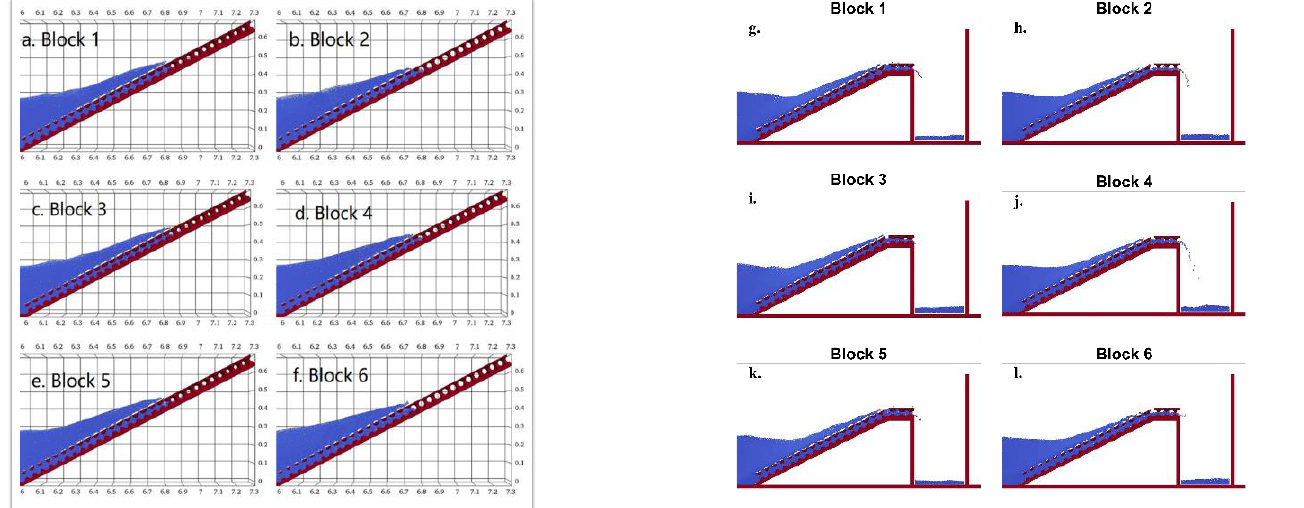
Figure 5. Wave run-up ( a – f ) and overtopping ( g – l ) snapshots for different type of blocks.